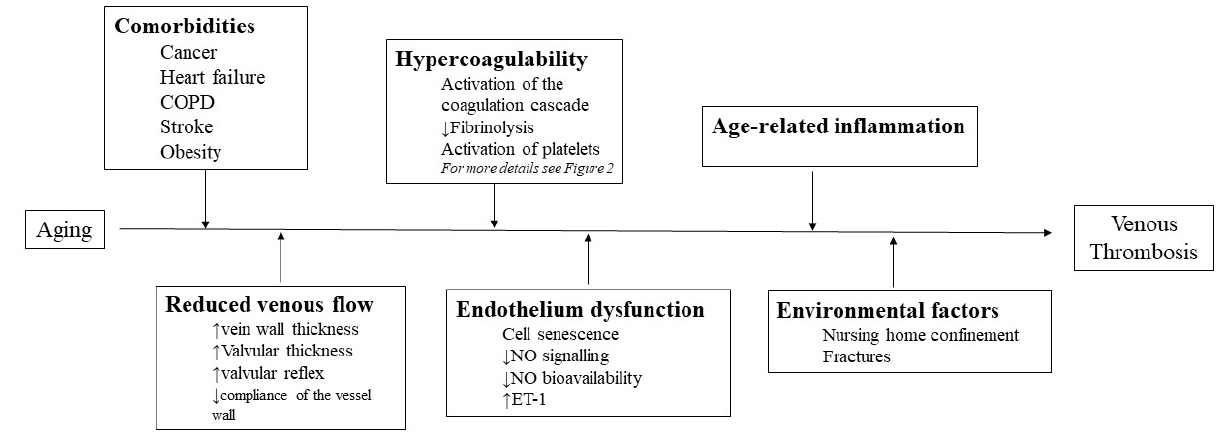
Figure 1. The main mechanisms underlying the impact of aging in VTE. Some of the factors are interrelated (see text for details). ↑ : up-regulation, ↓ : down-regulation